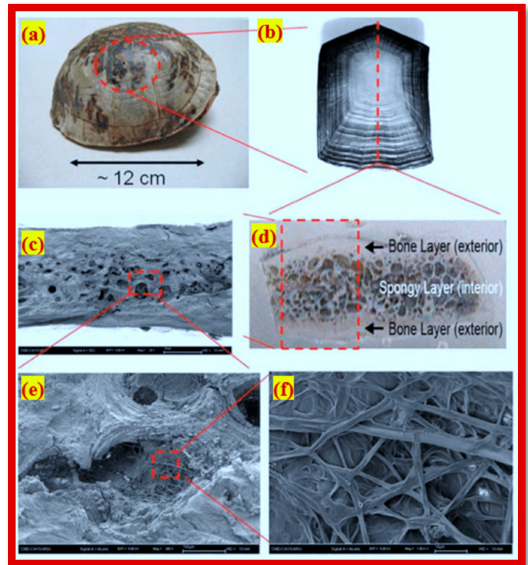
Figure 1. Multiscale hierarchy and the shell of turtle; ( a ) a morphology of the shell structure of turtle, ( b ) a costal scute indicating the sequent pattern of growth pattern, ( c ) scanning electron microscope of the surface fractured, ( d ) a cross-section of carapace displaying a composite layer ( e ) scanning electron microscope of the cell structure and ( f ) scanning electron microscope image of fibrous structure interior of the